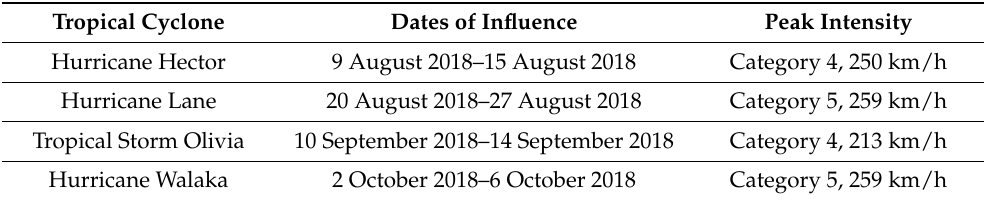
Table 1. Named storms, the approximate dates at which they influenced the study site (according to wind and wave data), peak intensity (Saffir–Simpson Hurricane Wind Scale) along with 1-min maximum sustained wind speed at peak intensity [54–57]. Tropical Storm Olivia attained Category 4 intensity but weakened to a tropical storm prior to its influence on the Hawaiian Islands, as depicted in Figure